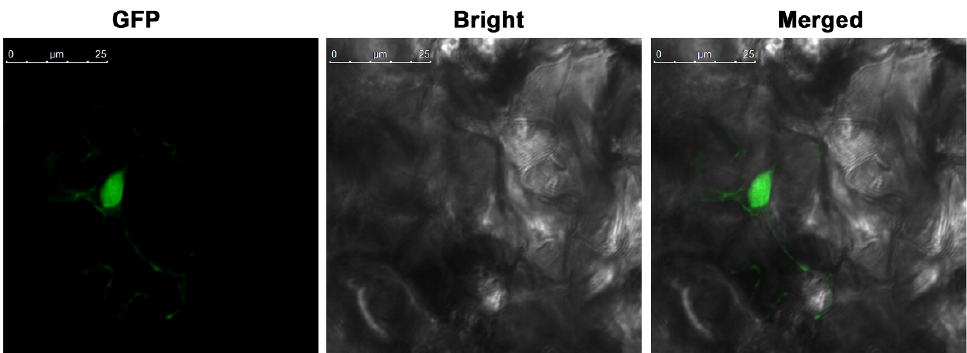
Figure 10. Analysis of PbGATA22 subcellular localization in tobacco leaf epidermal cells. Green fluorescent protein (GFP) fluorescence is shown in green color, Bars = 25 μm. Confocal images demonstrate the nucleus localization when transiently expressed in the epidermal cells of N. benthamiana leaves.